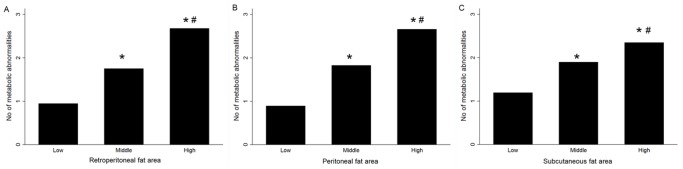
Clustering of metabolic abnormalities defined by MS in participants with body fat areas in the lowest, middle, or highest tertiles.(A) Retroperitoneal fat, (B) peritoneal fat, and (C) subcutaneous fat. *p<0.05 vs. lowest tertile, #p<0.05 vs. middle tertile.